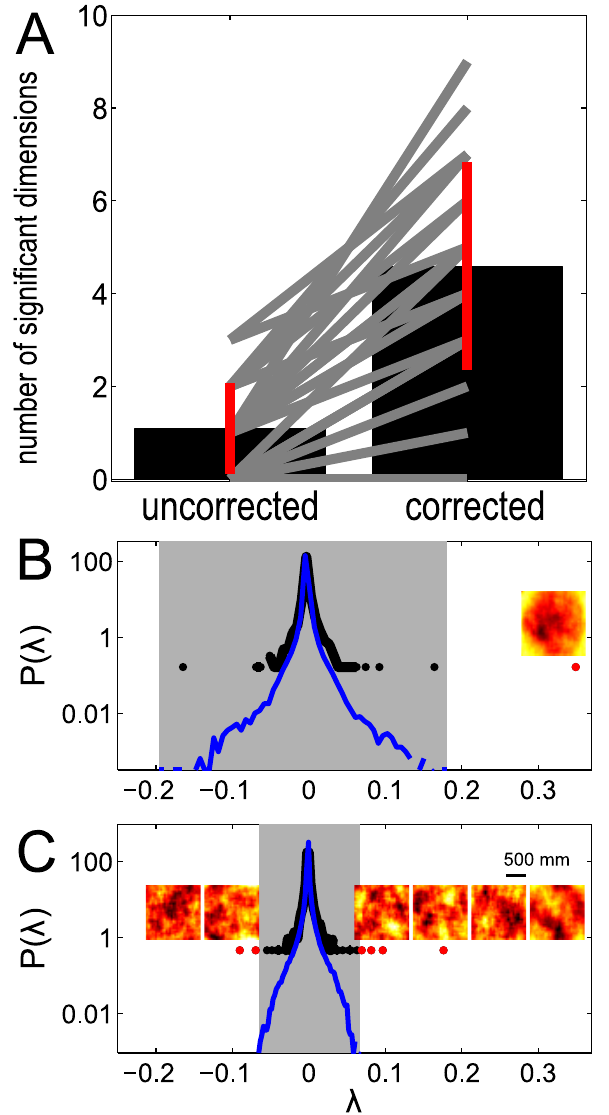
Figure 5. Analysis of salamander retinal ganglion cells. (A) Number of significant dimensions for 22 RGCs presented with a strongly correlated stimulus, before ( left ) and after ( right ) using our correction scheme. Gray lines represent single cells, and red lines represent the standard deviation. (B) Significant (insignificant) eigenvalues of D C in red (black) and the null eigenvalue distribution (blue) for an example cell. Null distribution were constructed using the global approach with 500 shuffled spike trains. Without the correction scheme there is only one significant dimension. The corresponding visual feature is shown in the inset before decorrelation. (C) Same for the corrected covariance matrix D ~ CC . Here there are six significant dimensions with spots likely representing the subunits within the cell’s receptive field. The gray shade indicates the range of the null distribution used to determine